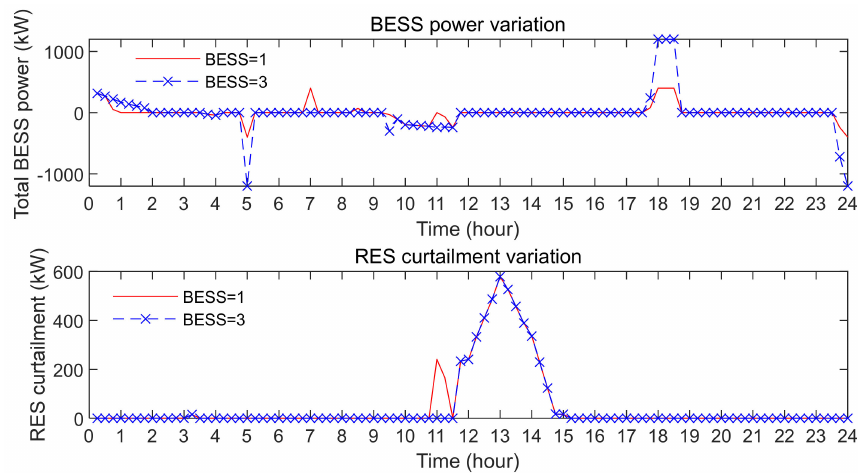
Figure 8. Variations of BESS power and RES curtailment for load type A (the distribution operator cannot sell electricity to the utility grid).